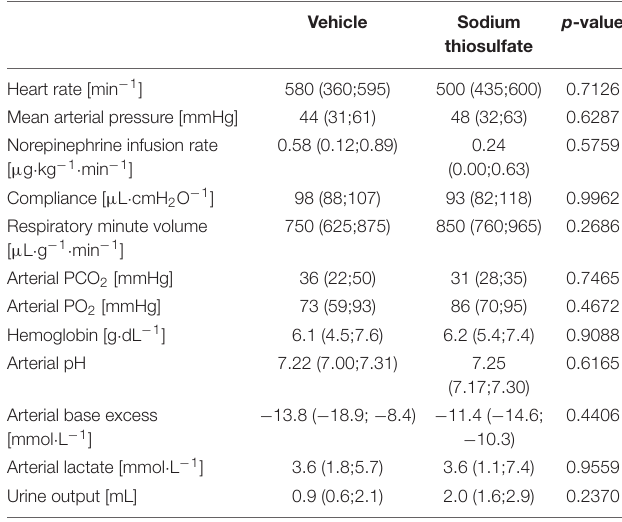
All data are median (interquartile range), n = 9 in both groups.